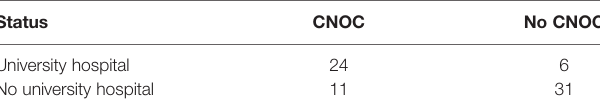
TABLE 1 | Squared table of department af fi liation to CNOC versus